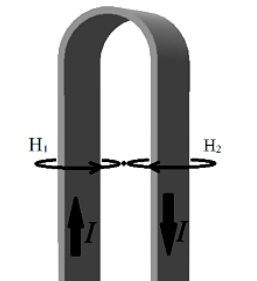
Fig. 4. Brake resistor tape element and current